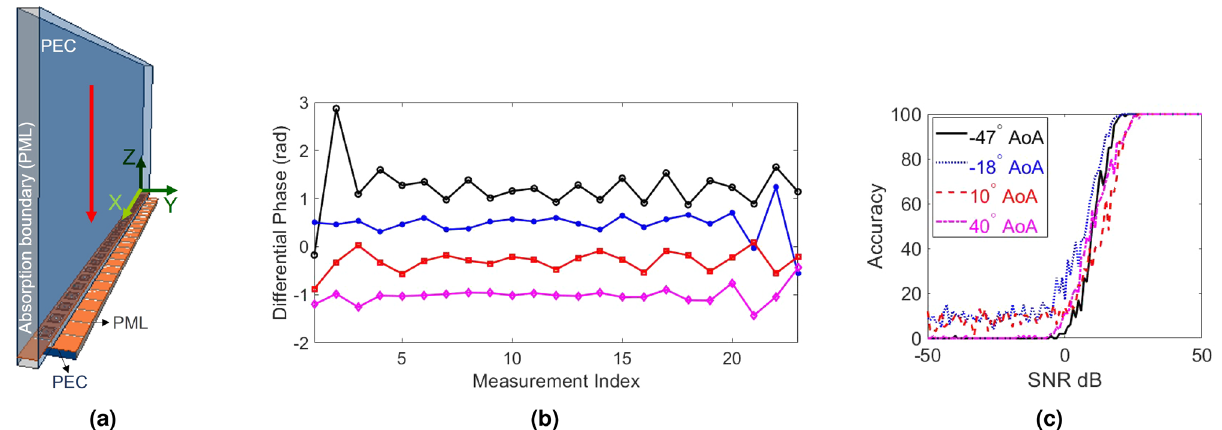
Figure 3. ( a ) The setup for illuminating the RIS with a Gaussian beam. The red arrow indicates the normal incidence. PML refer to perfectly matched layer. ( b ) Differential phase along the 1D metasurface array for four different incident angles captured inside SIWs. ( c ) AoA estimation accuracy (in percentage) as a function of the signal-to-noise ratio (SNR). The incident angles are the same in both